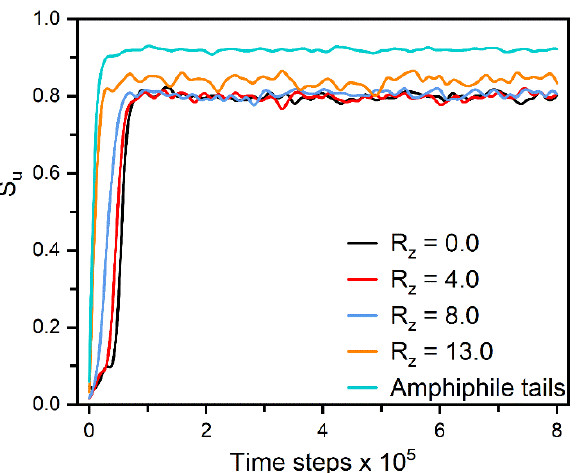
Figure 6. Time evolution of the orientational order parameter for the amphiphile tails and mesogens in slabs along the z axis when directly cooling a disordered configuration with ρ s = 0.85 to the homeotropic nematic anchoring at T = 0.6. Each slab with a center locating at R z has a thickness of 4.0, and the slab with R z = 0.0 is just in the center of bulk LCs. Instantaneous snapshots of six representative configurations in this ordering process are displayed in Figure